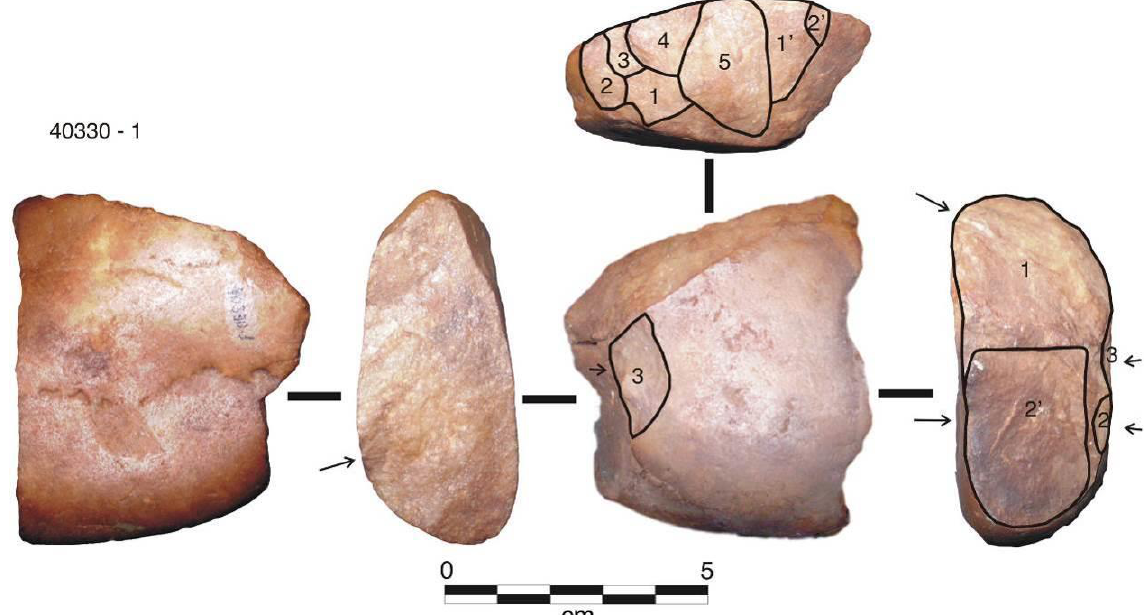
Figure 7. Core on quartz pebbles from Pleistocene layer of Sitio do Meio, Pedra Furada 3 phase, older than uncal. 12,640 BP. Note the high number of flake-scars. (Photo by G.